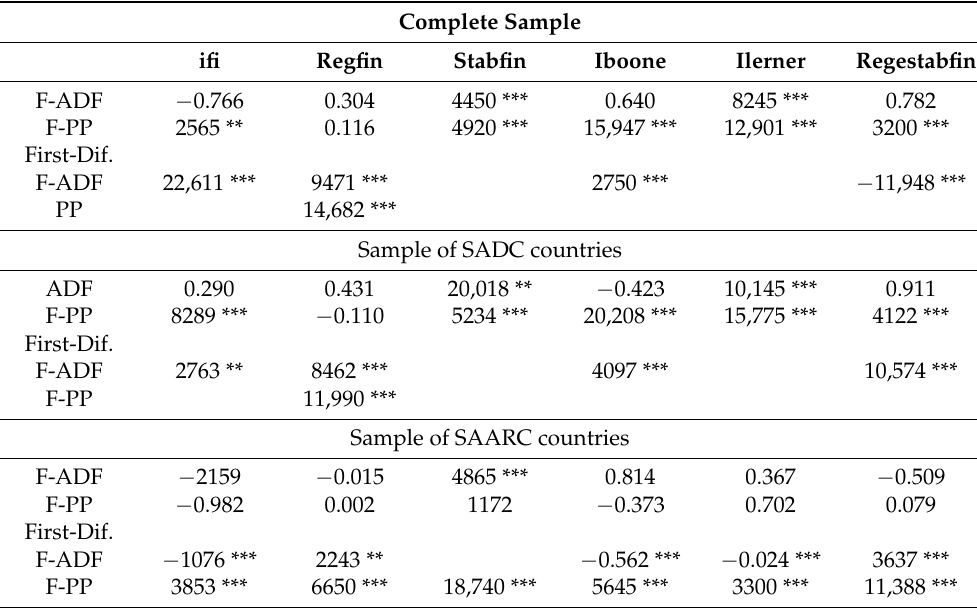
Table 4. Panel unit root test for the main variables of the study (endogenous and exogenous). Complete Sample ifi Regfin Stabfin Iboone Ilerner Regestabfin